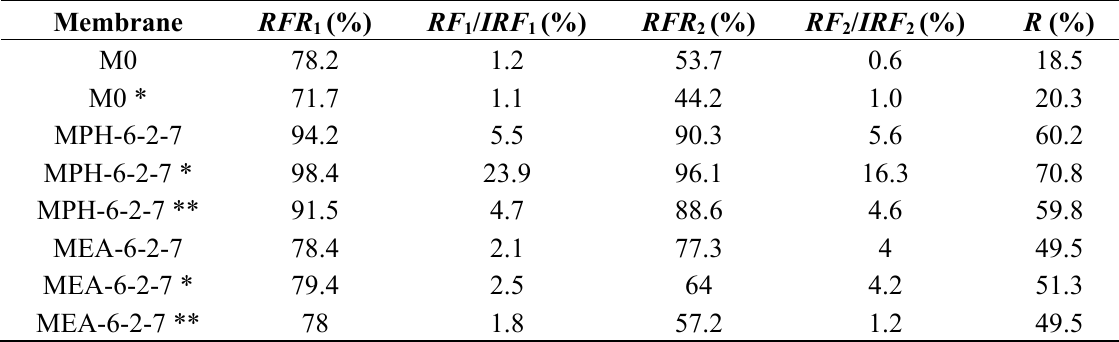
Table 3. The fouling-resistance of various